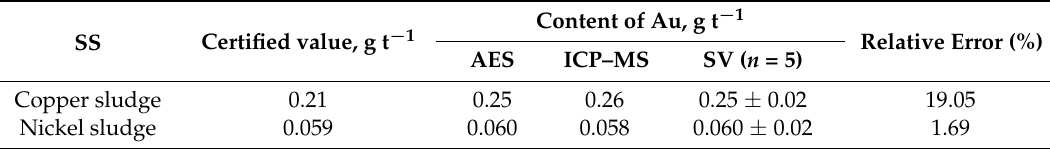
Table 3. Results of determination of gold in standard samples (SS) of copper and nickel sludge analyzed by different methods.